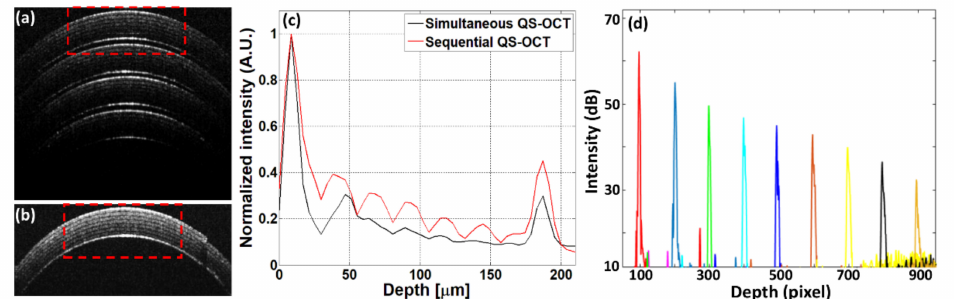
Figure 5. The performance difference between the simultaneous and sequential quad-scanner (QS) OCT system and the measured intensity fall-off of the proposed system. ( a ) is the cross-sectional OCT image of the simultaneous QS-OCT system. ( b ) is the cross-sectional OCT image of the sequential QS- OCT system. ( c ) is the depth intensity profiles of the simultaneous and sequential QS-OCT systems. ( d ) is the measured intensity fall-off graph of the proposed system obtained every 100 pixels.